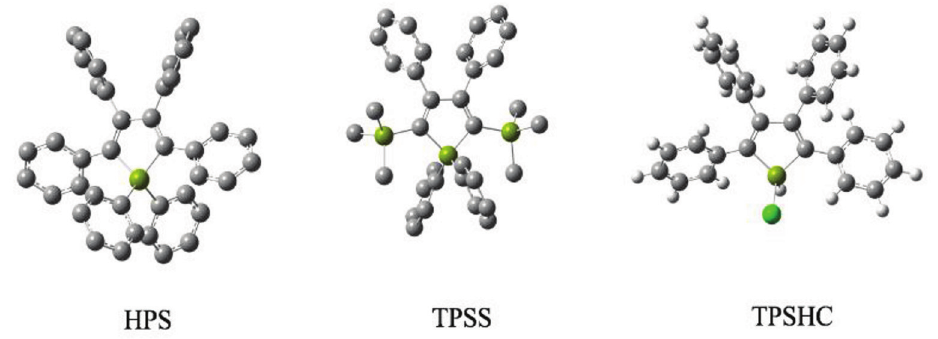
Figure 3: The optimized molecular structures of TPSHC, TPSS, and HPS.